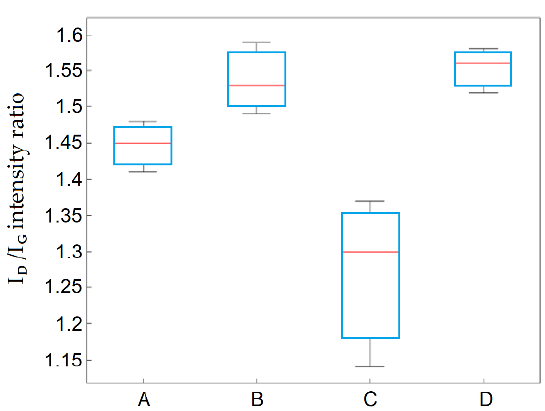
Figure 5. Diagram of between-group variation for I D /I G as a function of the applied method. The deconvolution of the 2D band and intensity ratios I 2D to I G (I 2D /I G ) and I 2D to I D+D’ (I 2D /I D+D’ ) showed that graphite oxides obtained using method D were composed of packets with the lowest numbers of graphene layers and the highest degrees of defective structures compared to those oxides obtained with the other methods. The differences in the I 2D /I G ratios of the graphite oxides obtained using method D were statistically